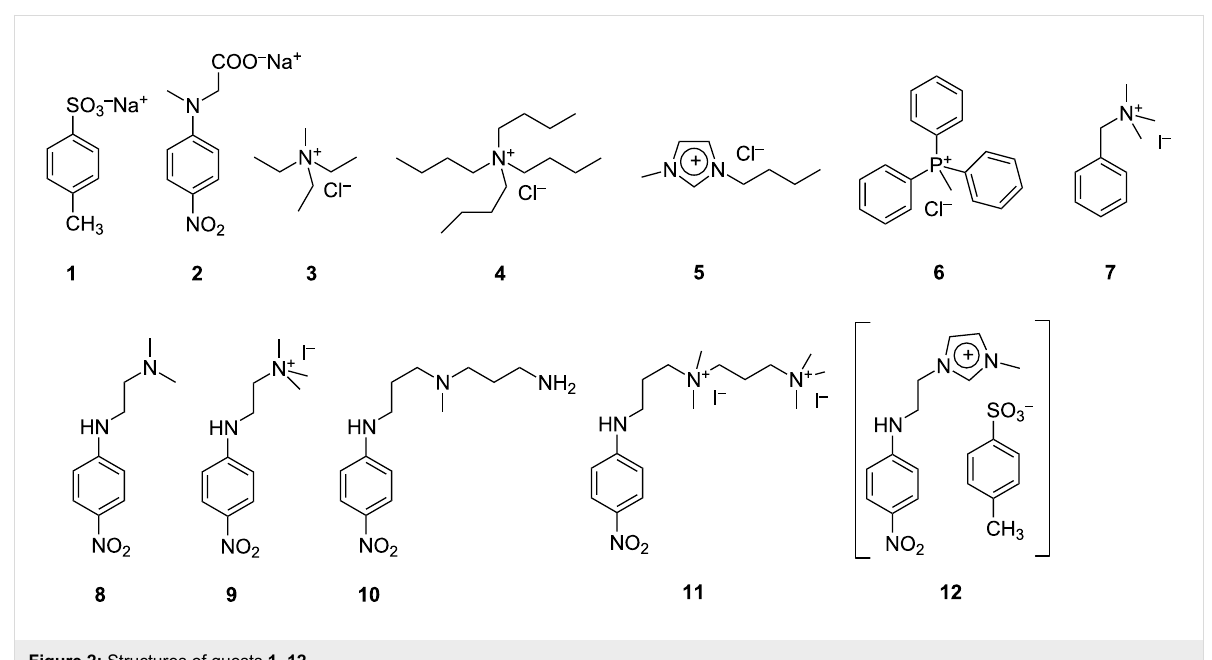
Figure 2: Structures of guests 1 – 12 .